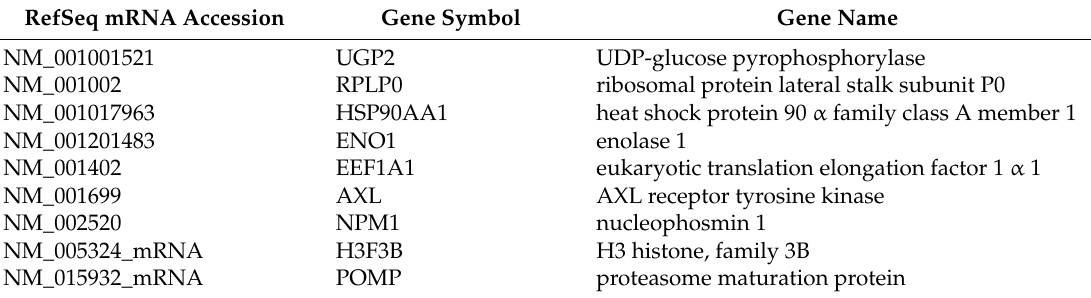
Table 1. Genes detected commonly in MDA-MB-231 and7 MCF-7 cells. Libraries that had at least one gene with 200 reads were qualified for mapping using RefSeq IDs. The genes displayed in the table were detected both in the MDA-MB-231 and MCF-7